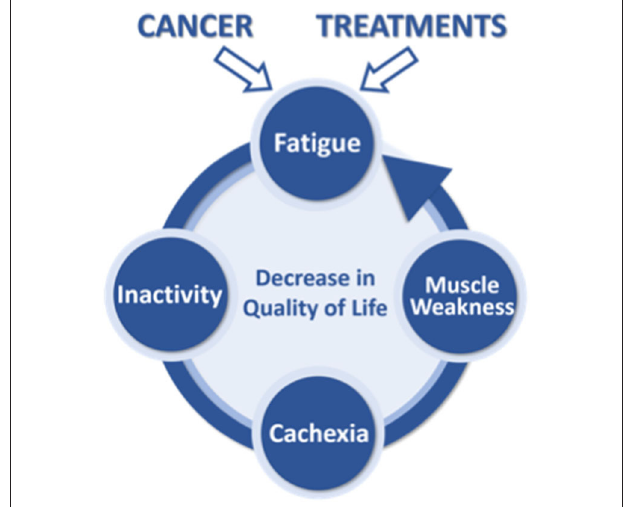
FIGURE 1 | Illustration of the theoretical cachexia–fatigue vicious